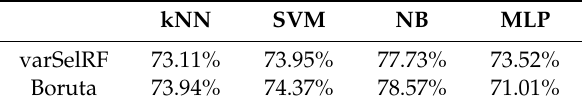
Table 4. Average classification accuracy for malicious intention detection.